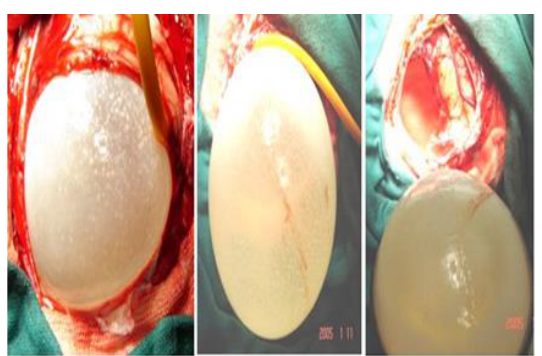
Figure 4. Surgery of cerebral hydatid